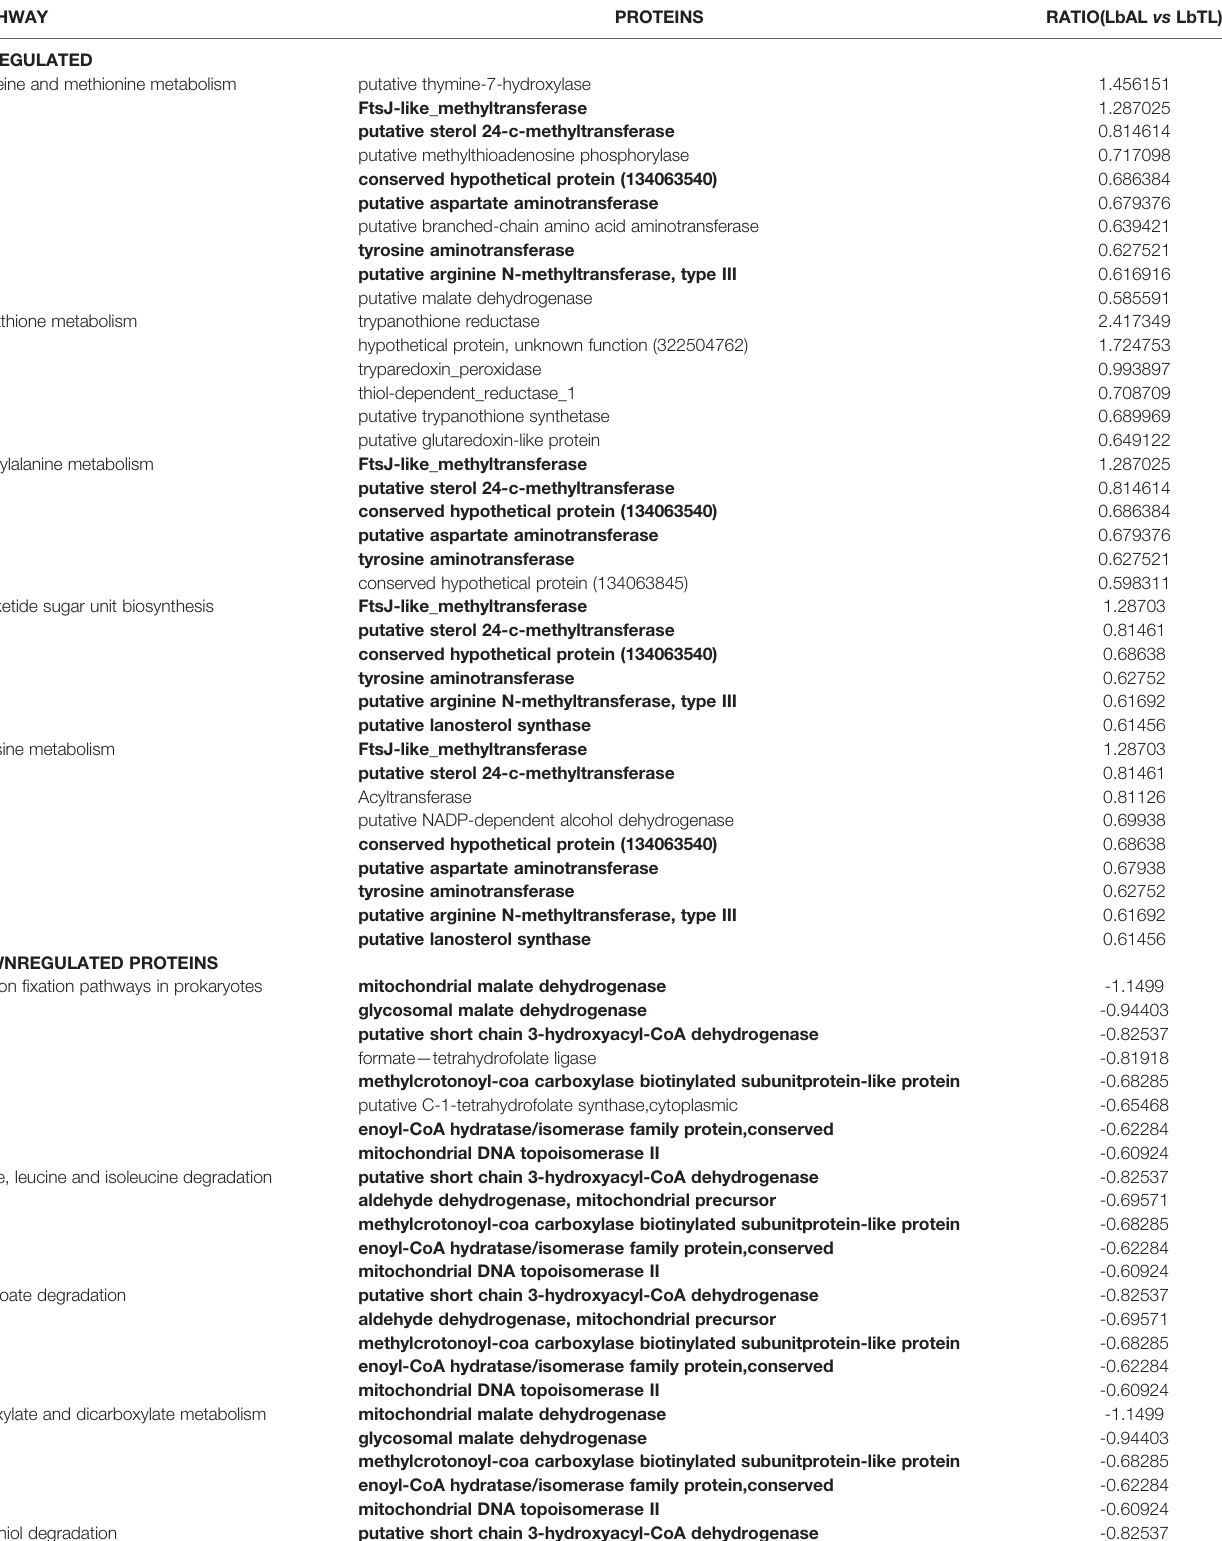
TABLE 3 | KEGG enriched pathways of differentially regulated proteins in L. braziliensis from atypical lesion (LbAL) compared to L. braziliensis from typical lesion